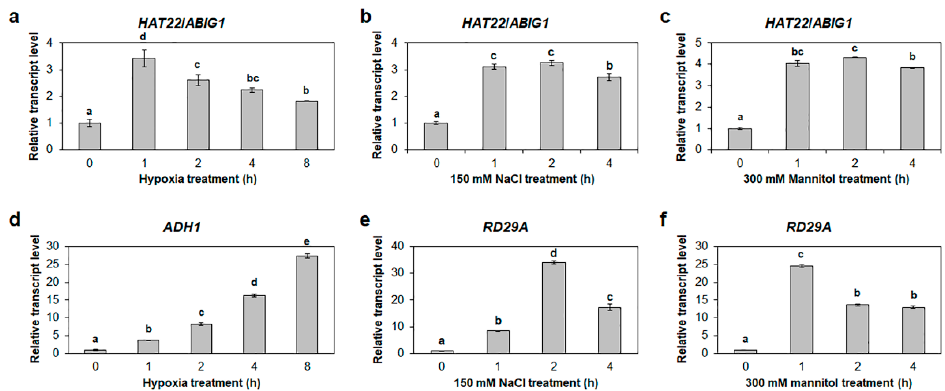
Figure 10. Expression of HAT22 / ABIG1 under osmotic stress and hypoxic conditions. ( a , b ) Quantitative RT-PCR (RT-qPCR) analysis for HAT22 / ABIG1 ( a ) and ADH1 ( d ) in WT seedling upon treatment with 99.9% N 2 gas for 0, 1, 2, 4, and 8 h under dark conditions. ( b , e ) RT-qPCR analysis for HAT22 / ABIG1 ( b ) and RD29A ( e ) in WT seedling upon treatment with 150 mM NaCl for 0, 1, 2, and 4 h. ( c , f ) RT-qPCR analysis for HAT22 / ABIG1 ( c ) and RD29A ( f ) in WT seedling upon treatment with 300 mM mannitol for 0, 1, 2, and 4 h. Glyceraldehyde 3-phosphate dehydrogenase ( GAPc ) was used for an endogenous reference gene. Transcript levels at 0 h were set to 1. Data are shown as means ± S.D. ( n = 3). At least three biological replicates showed similar results; representative results are shown here. Different letters display significant differences ( p <